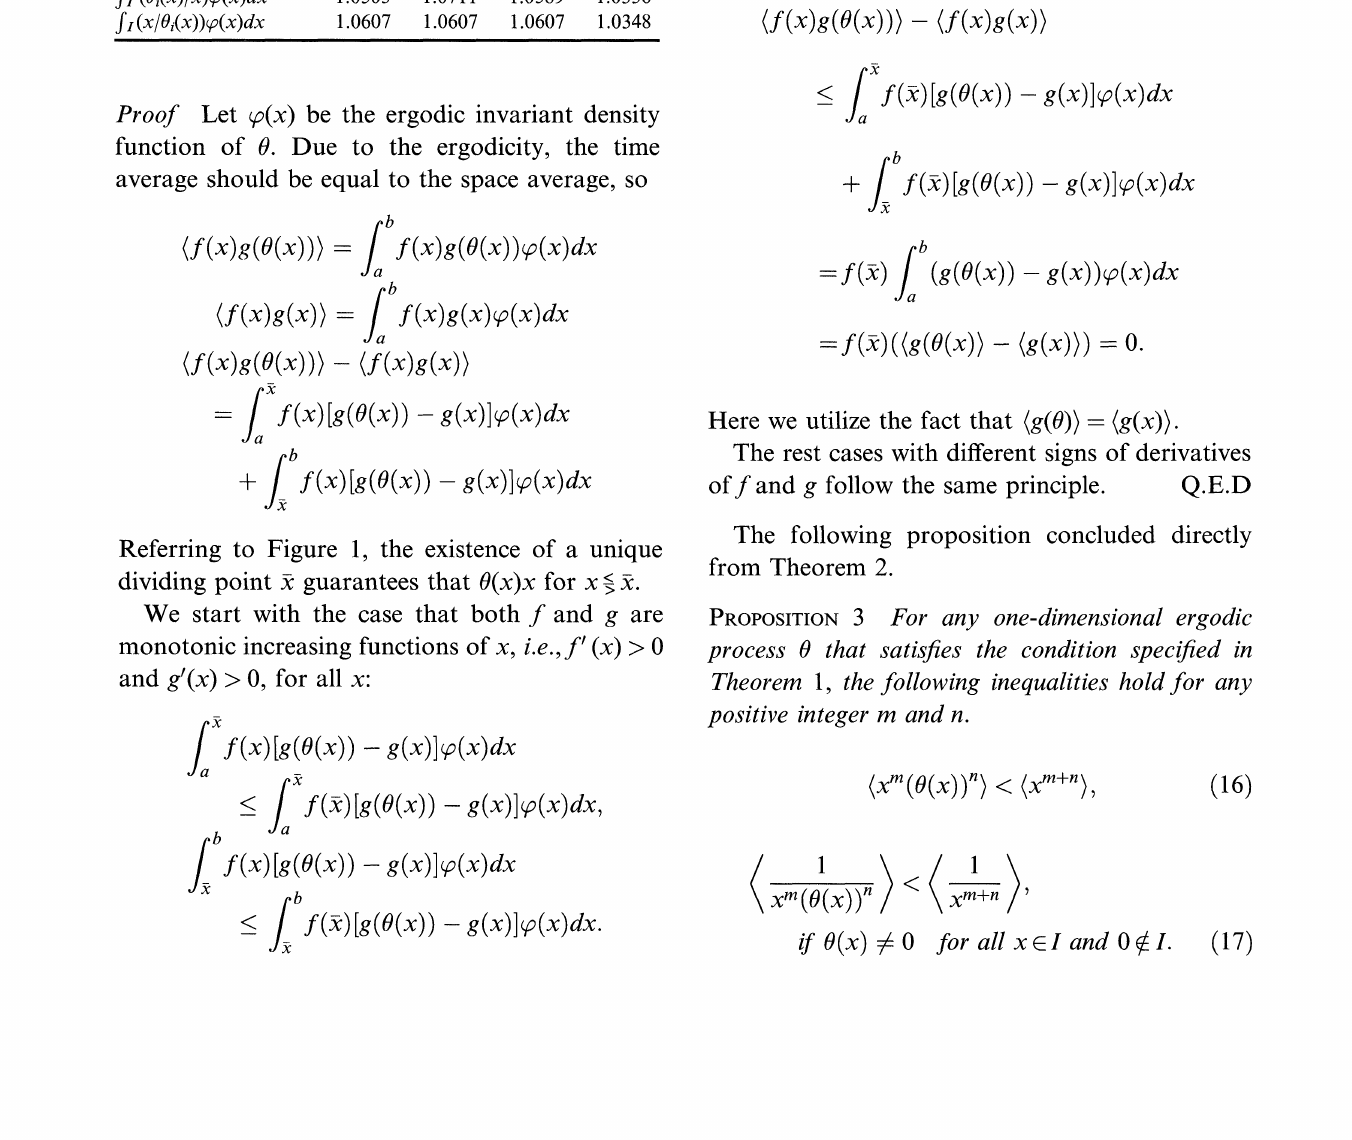
FIGURE 4 Computer simulations II. TABLE II Illustration of inequality